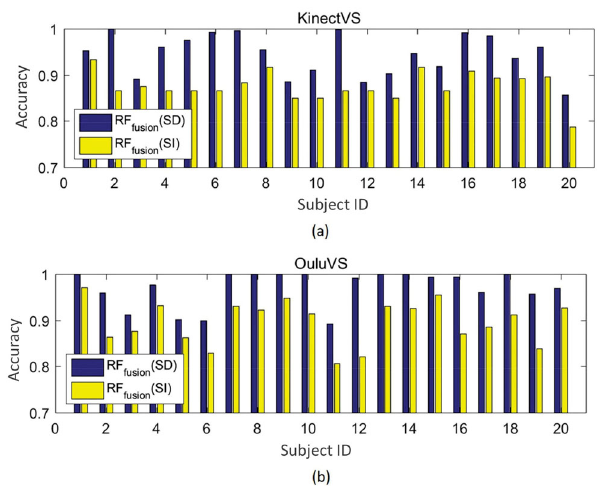
Fig. 12 Phrase recognition accuracies for each subject in (a) KinectVS and (b) OuluVS datasets by the RF fusion in the subject- dependent (SD) and independent (SI) experiments.